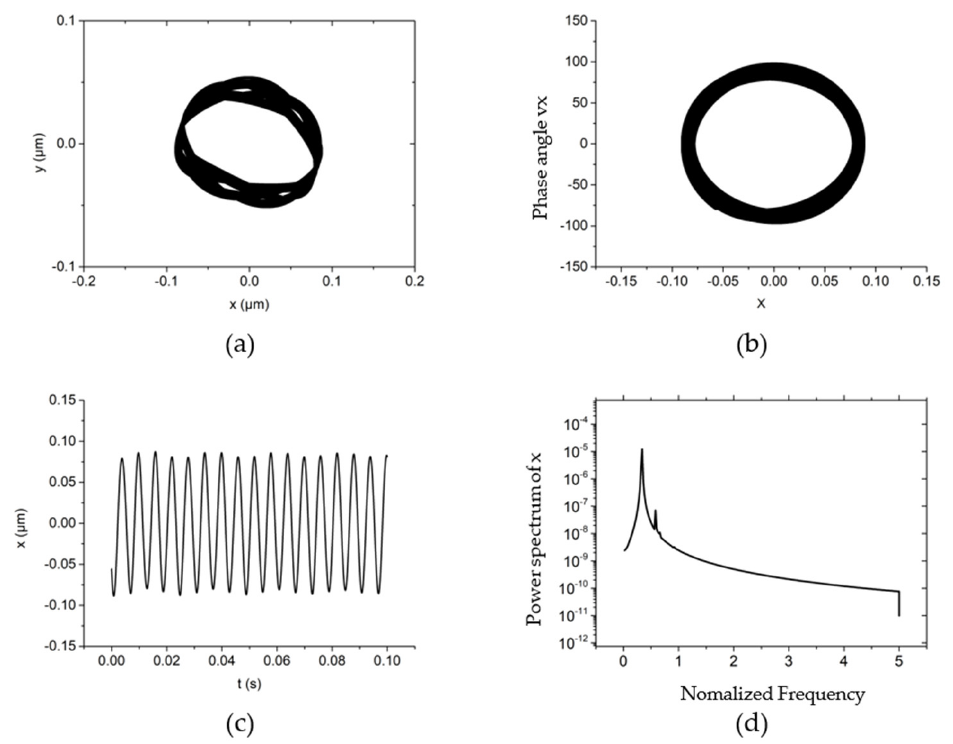
Figure 7. The non − linear dynamic behavior of the rotor at w = 50,000 r/min, Fy = 30 N, m u = 0.1 g, m m = 90 g. ( a ) Rotor center trajectory, ( b ) Phase angle in x direction, ( c ) X displacement time-domain curve, ( d ) Power spectral density in the x direction.